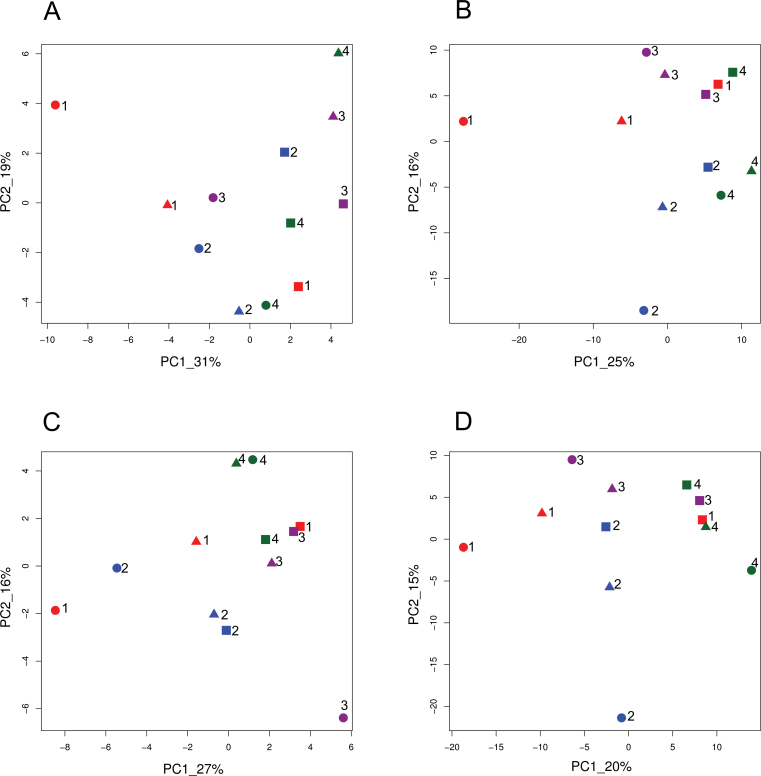
First plans of the principal component analysis showing the variation of 12 genotypes based on (A) metabolite contents, enzyme activities, and phenotypic traits at the cell expansion stage; (B) proteins at cell expansion; (C) metabolite contents, enzyme activities, and phenotypic traits at the orange-red stage, and (D) proteins at the orange-red stage. Values along the axes indicate the percentage of total variation accounted for by each component. Genotypes are indicated with different symbols, S. lycopersicum squares, S. lycopersicum var. cerasiforme circles, and F1 triangles. Levovil×Cervil (1), Stupicke Polni Rane×Criollo (2), LA0147×Plovdiv 24A (3), Ferum×LA1420 (4). (This figure is available in colour at JXB online.)